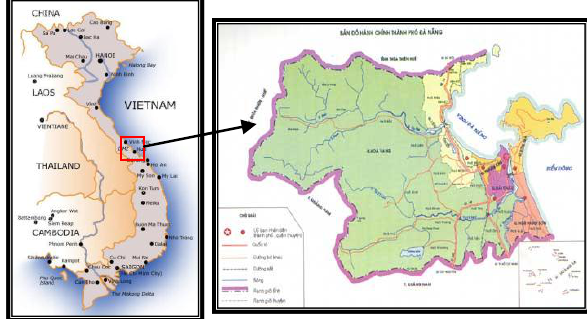
Figure 1. General location of Danang city, Vietnam